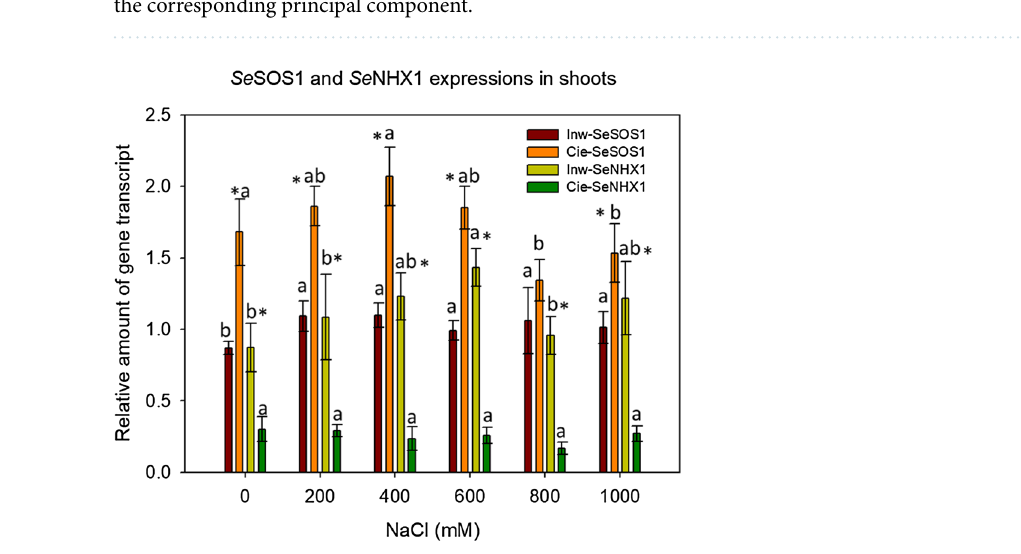
Figure 8. Expression analysis of Se NHX1 and SeSOS1 genes involved in sodium segregation in shoots of S. europaea under different NaCl concentrations. Means and ± SD of replicates. Different letters indicate significant differences between treatments within population and * indicates significant difference between populations within treatment (p < 0.05), n = 3. The F values that correspond to the 2-way ANOVA for the interaction salt treatment × population are F 5,24 = 2.7; p = 0.03 and F 5,24 = 3.6; p = 0.01 for Se NHX1 and SeSOS1 genes